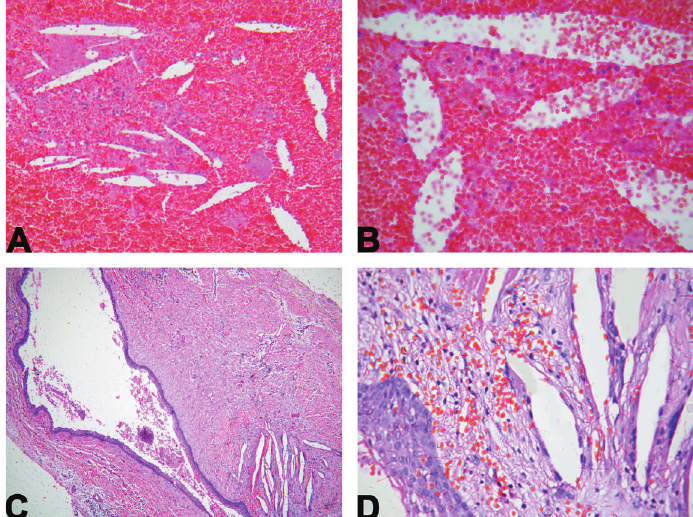
Figure 2- A, cytological analysis (cell block) of an inflammatory cyst [hematoxylin-eosin (H&E)100x]; B, high magnification showing cholesterol clefts and a large number of erythrocytes (H&E 400x); C, histopathological analysis of the same lesion showing a cystic capsule with epithelial lining (H&E 100x); D, high magnification showing cholesterol clefts inside the capsule